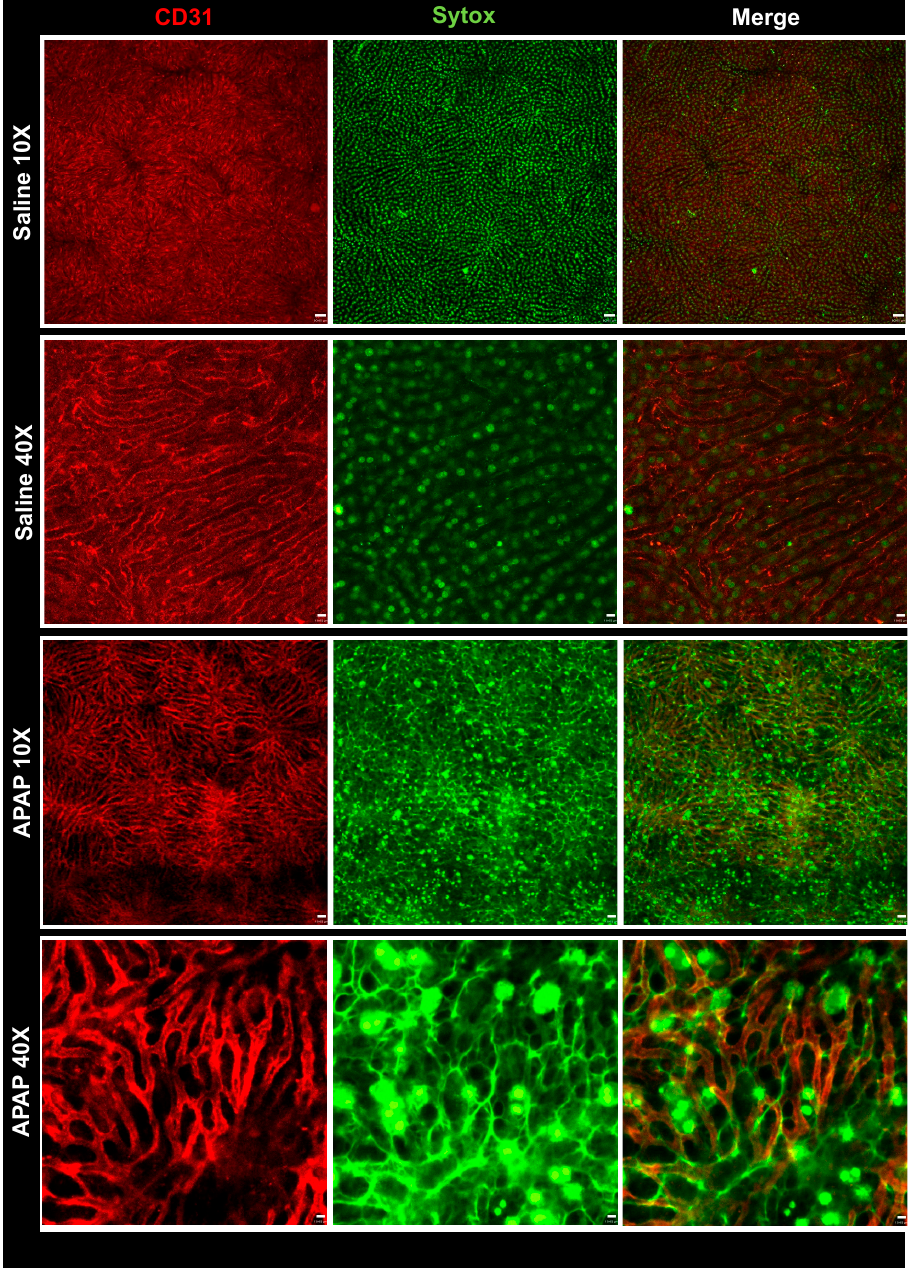
Figure 2. Intravital confirmation of DNA deposition in liver microvasculature during APAP-induced injury. Mice were treated with APAP and after 12 h were prepared for intravital microscopy. Note the extensive extravascular DNA deposition within the vessels. Liver intravital microscopy from a saline-treated mouse (10 × magnification) showing ( A ) sinusoids, ( B ) DNA staining and ( C ) merged channels. Liver intravital microscopy from a saline-treated mouse (40 × magnification) showing ( D ) sinusoids, ( E ) DNA staining and ( F ) merged channels. Liver intravital microscopy from an APAP-challenged mouse 10 × magnification showing ( G ) sinusoids, ( H ) DNA deposition and ( I ) merged image. Liver intravital microscopy from an APAP-challenged mouse 10 × magnification showing ( J ) sinusoids, ( K ) DNA deposition and ( L ) merged channels. Arrows show intravascular areas of DNA accumulation; scale bar = 50 µ m (10 × ) and 13 µ m (40 × ). Green: Sytox Green; red: Phycoerythrin-conjugated